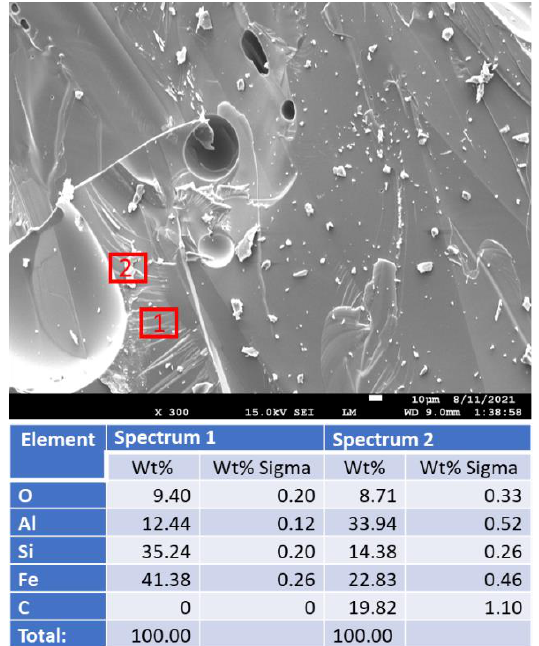
Figure 29. Photomicrograph of mullite sample with the elemental composition of typical sites shown by red boxes after alkaline carbonation at 250 °C for 40 days.